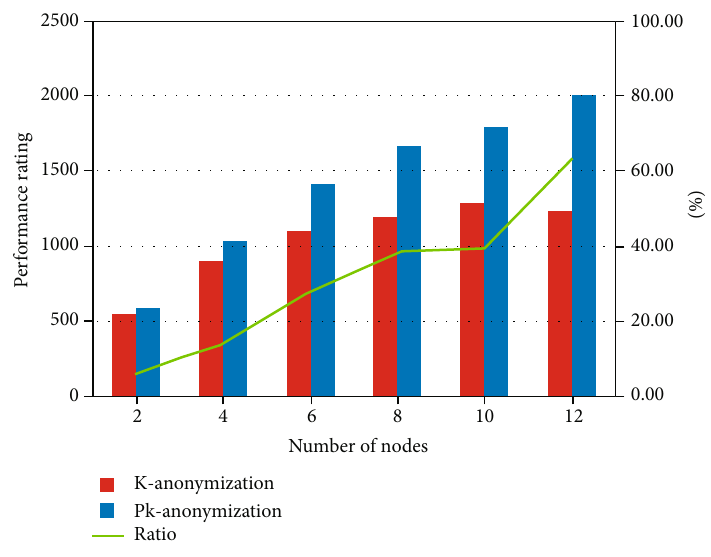
Figure 9: Performance rating